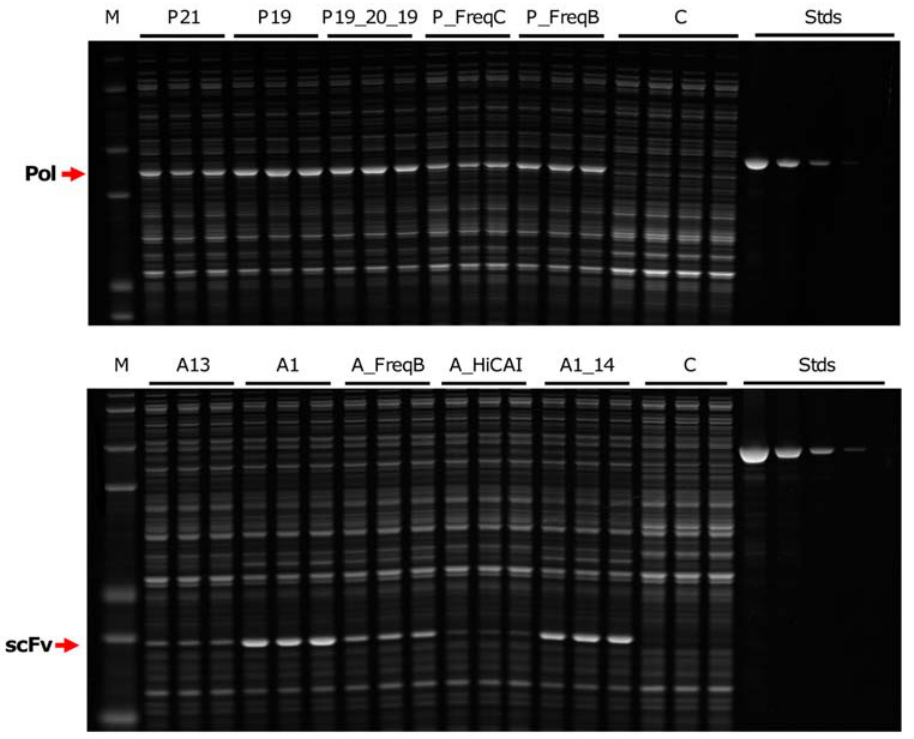
Figure 1. Protein expression from variant genes. Equal amounts of bacterial lysates were separated by polyacrylamide gel electrophoresis and stained with Sypro Ruby (Pierce). Three independent clones for each variant were measured. Variant names are indicated above the gel lanes. Also shown are molecular weight standards (M); negative control samples (C); BSA mass standards (Stds). Red arrows indicate positions of full-length phi29 DNA polymerase (top panel) or scFv (bottom panel). BSA standard lanes include 500, 250, 125, 62.5, and 25 ng total protein (top panel, left to right) or 1000, 500, 250, 125, and 50 ng total protein (bottom panel, left to right).